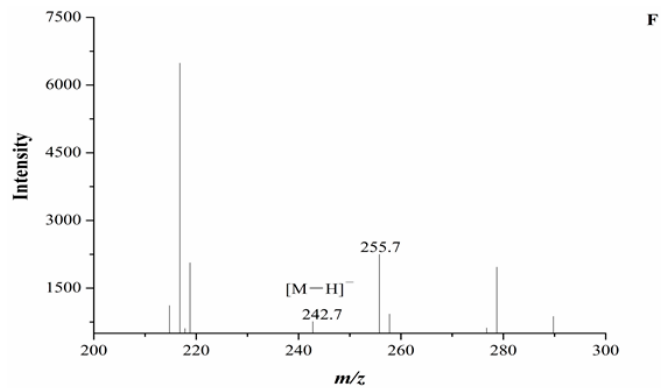
Figure 4. ESI/TOF-MS spectra of cordycepin, O . xuefengensis and O. sinensis in positive and negative ion modes. ( A ) Cordycepin in positive ion mode; ( B ) Cordycepin in negative ion mode; ( C ) The LC peaks O . xuefengensis in positive ion mode; ( D ) The LC peaks O . xuefengensis in negative ion mode; ( E ) The LC peaks of O. sinensis in positive ion mode; ( F ) The LC peaks of O. sinensis in negative ion mode.